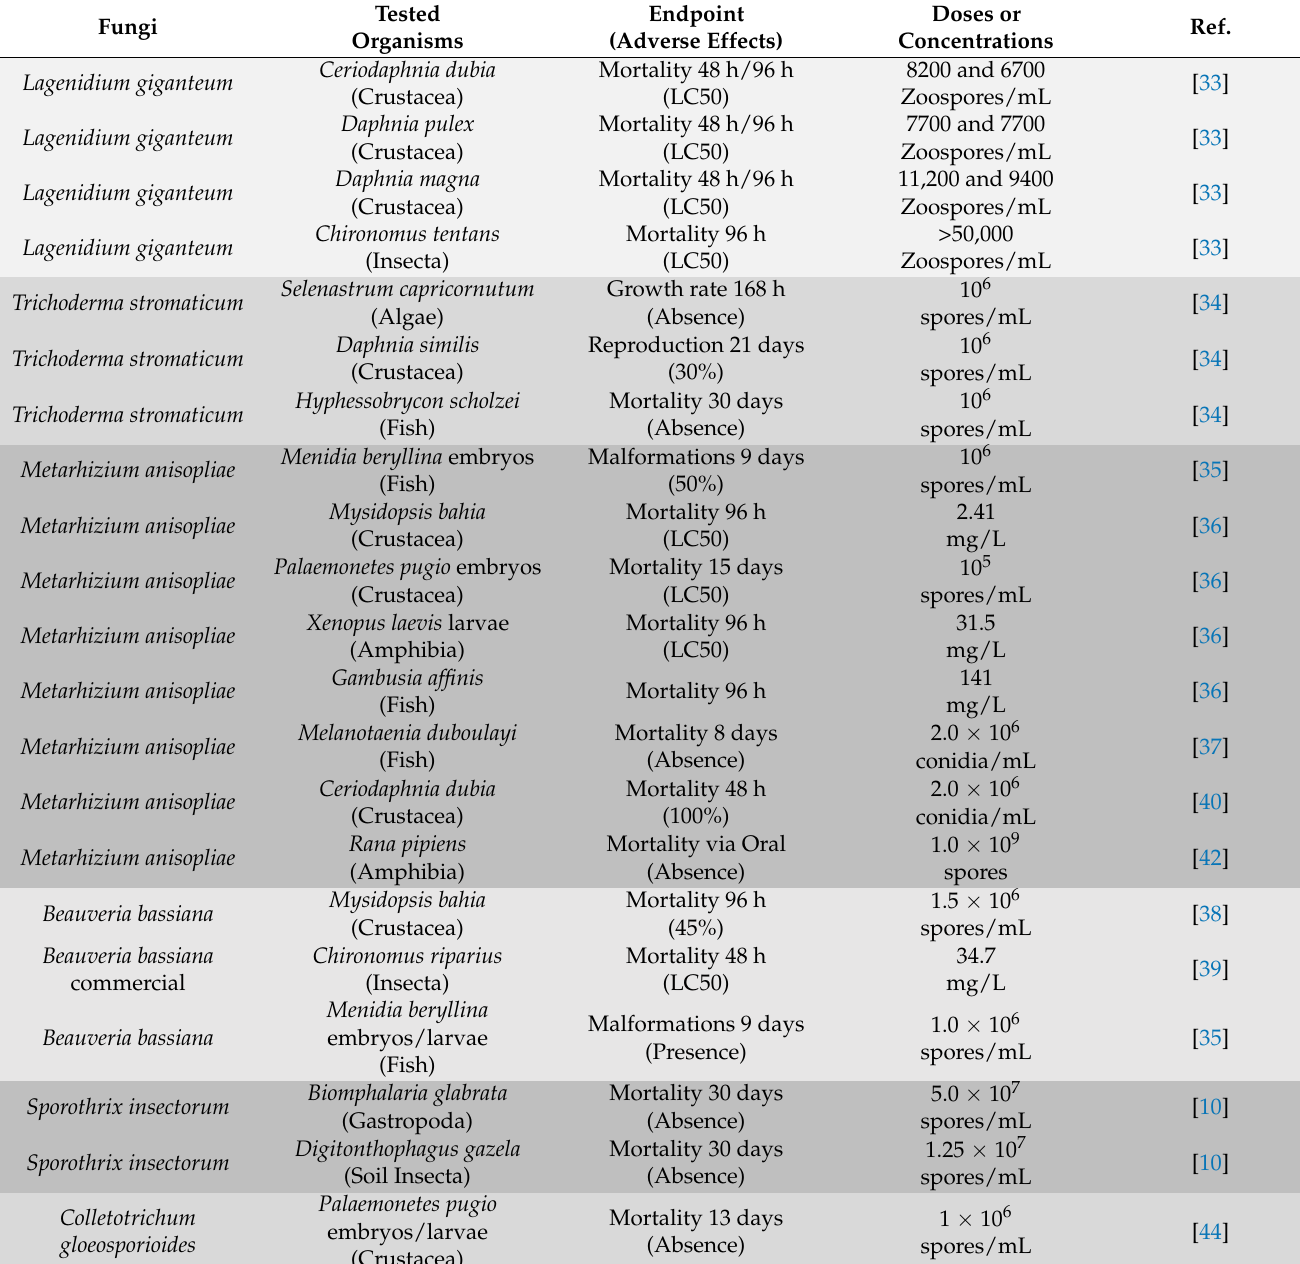
Table 2. Aquatic and terrestrial ecotoxicity of fungi-based